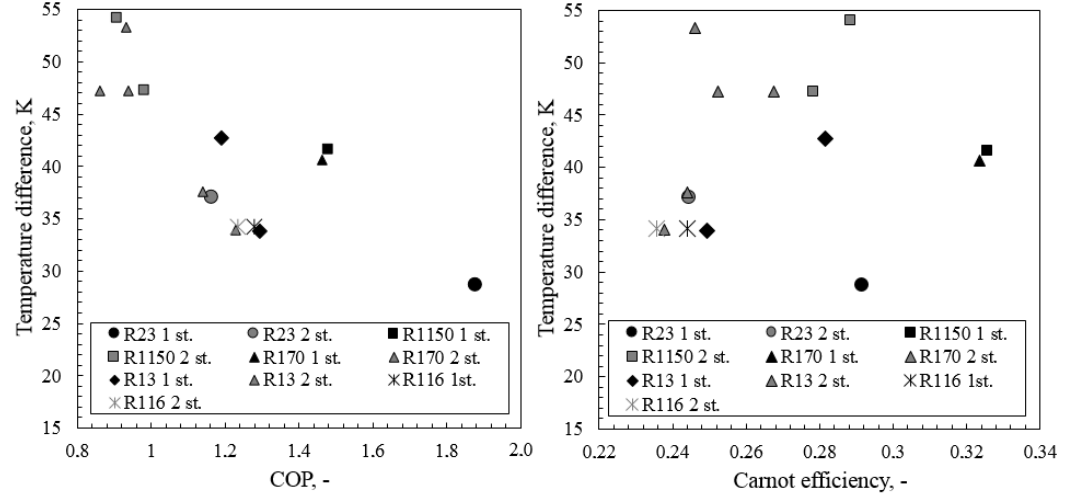
Figure 12. The performance of second-stage refrigerants.